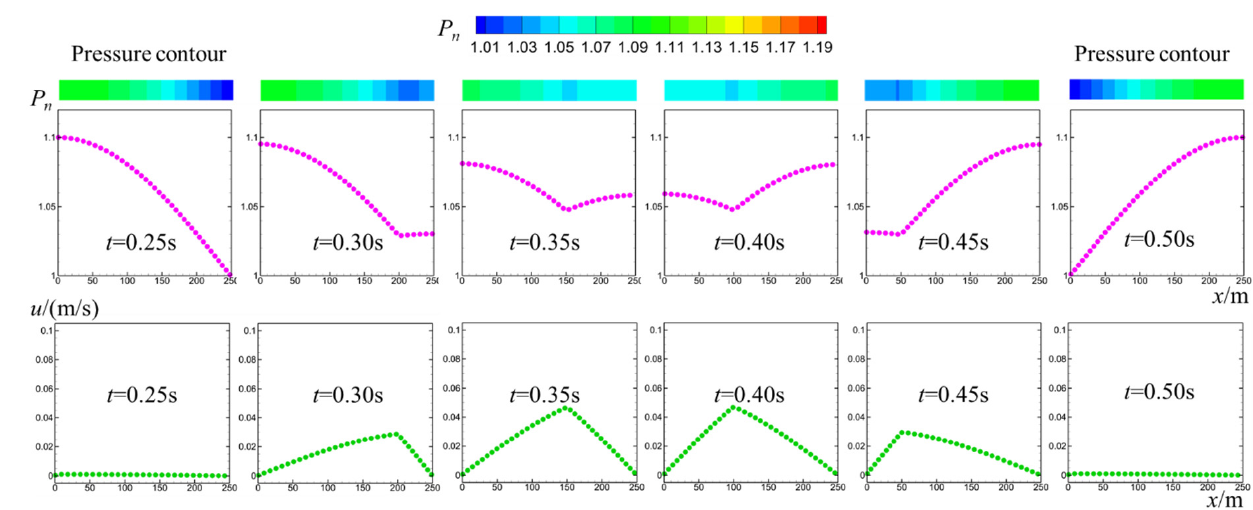
Figure 15. Normalized pressure–position P n - x curves (upper part) and velocity–position u - x curves (lower part) during 0.25 pulse-periods from t = 0.25 s to t = 0.5 s, where L x = 250 m and f = 1 Hz. The velocity is not zero at t = 0.25 s (shown in the lower left).